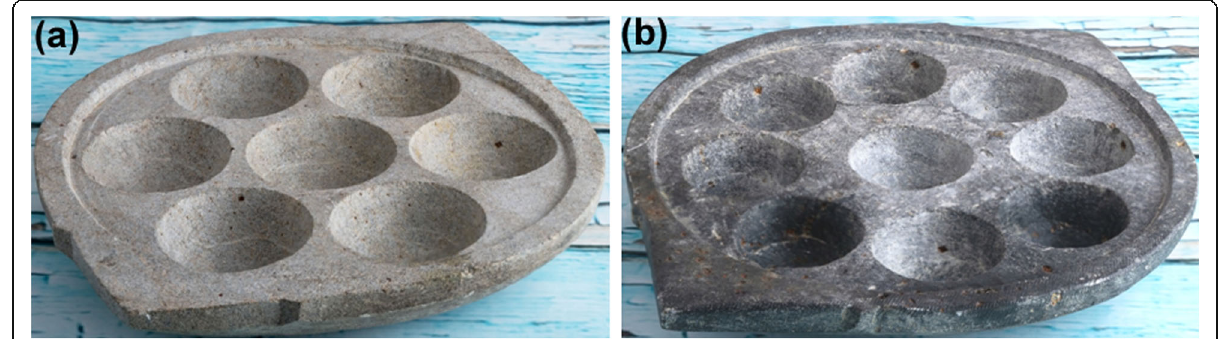
Fig. 7 The soapstone paniyaram chatti with a 7 pits and b 9 pits